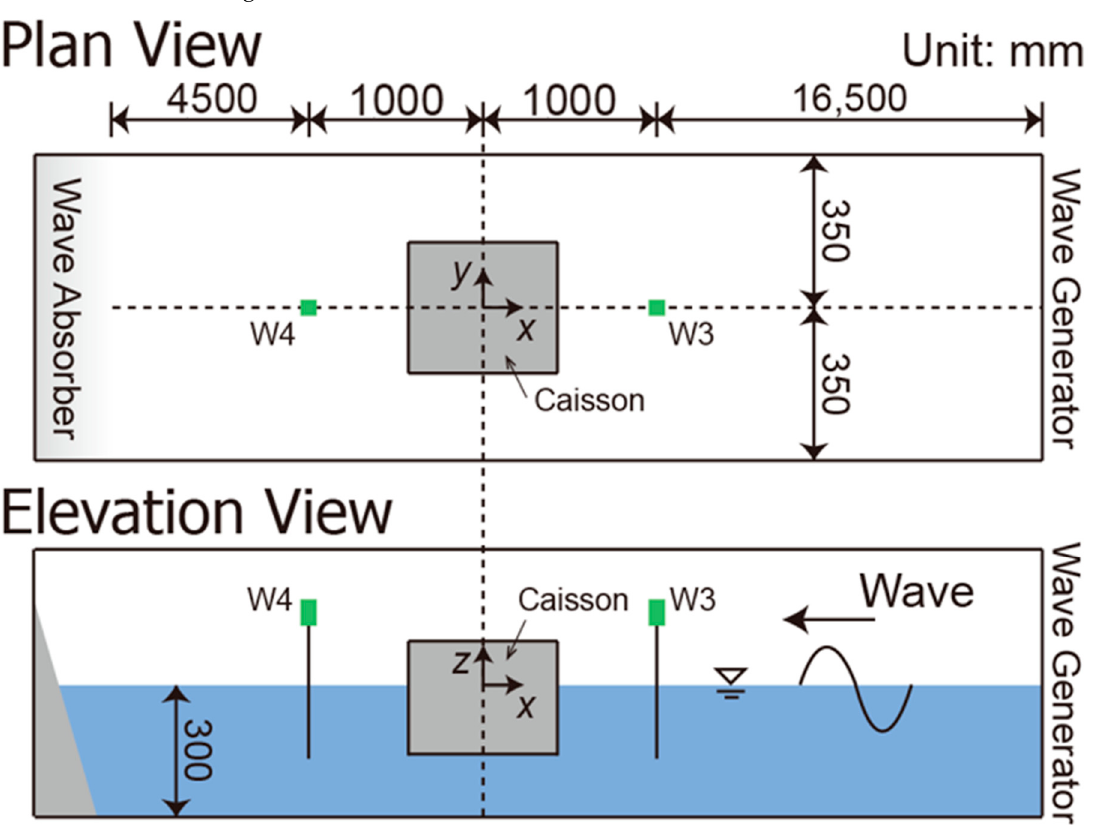
Figure 1. Wave flume (unit: mm; W3, W4: locations of the wave gauges).